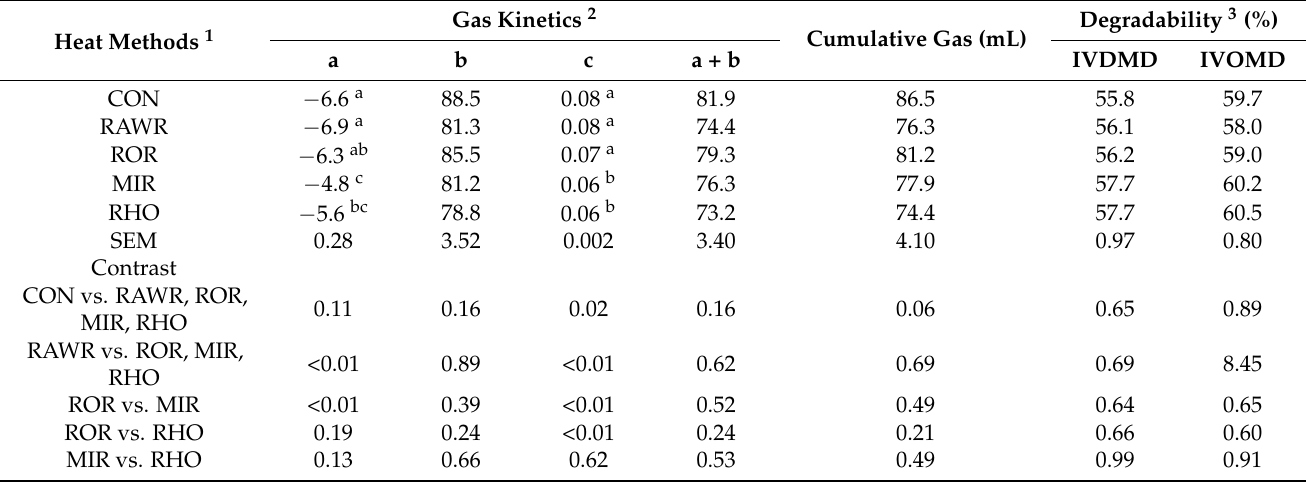
Table 3. Effect of different heating of rubber seed kernel on the kinetics of gas production and in vitro degradability.